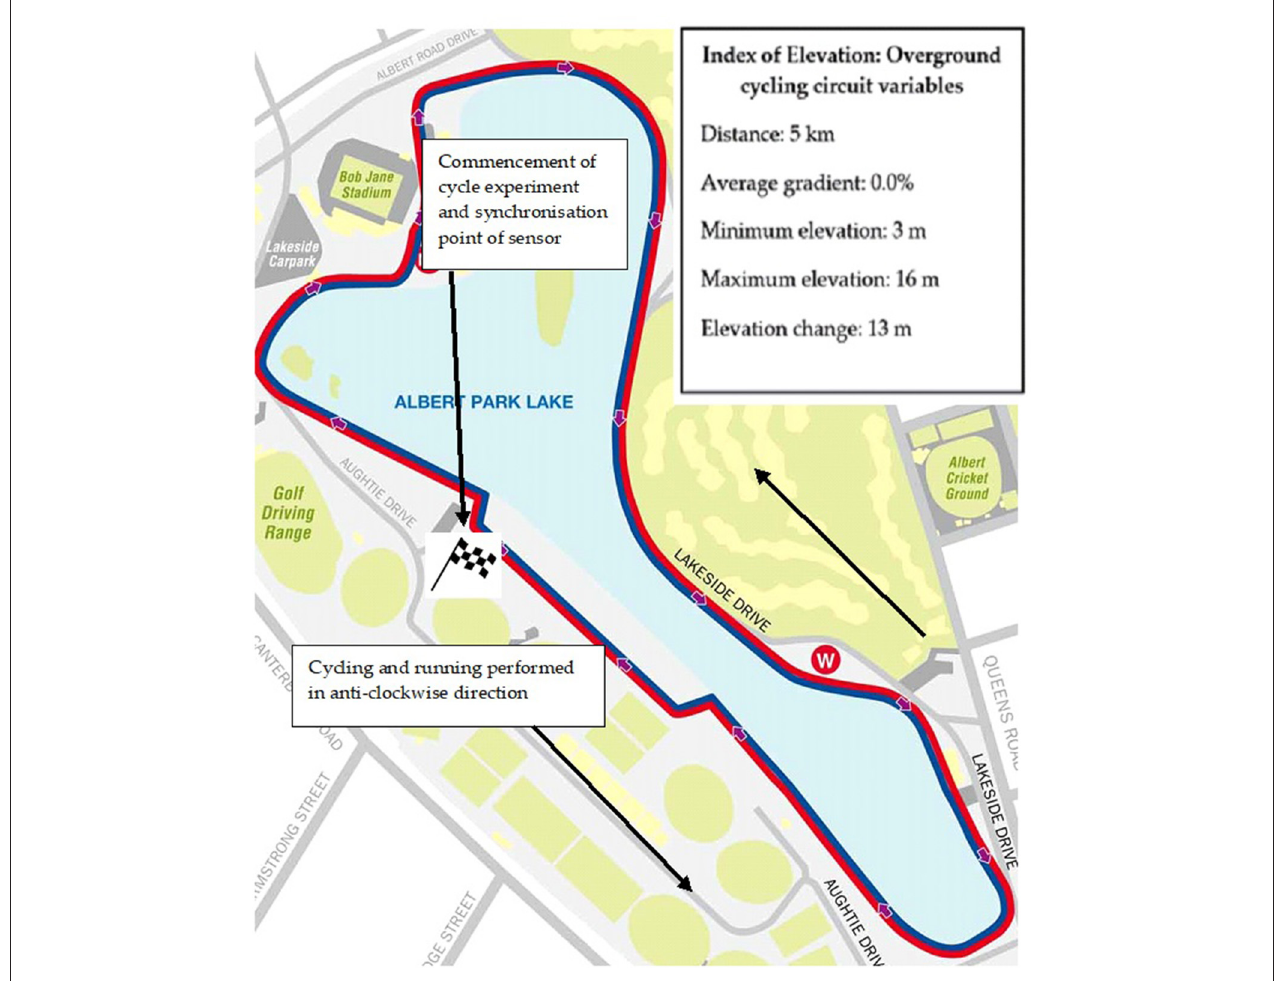
FIGURE 3 | Map view and location of both experiments. The index of elevation contains the course variables experienced by the participants during both experiments. The average gradient across the 5km circuit was 0%. Image retrieved from